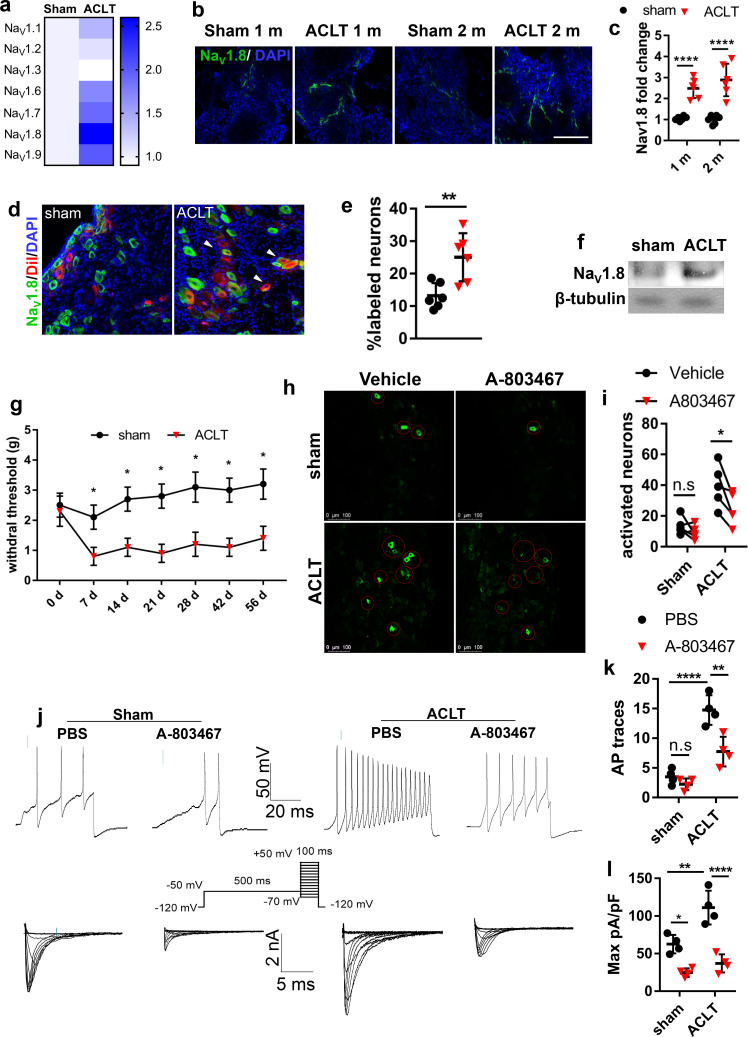
Nav1.8 modification after mice model of OA.(a) Heatmap of relative expression levels of NaV channels in ipsilateral L3-L5 DRGs after sham or ACLT surgery. (b, c) Immunostaining of NaV1.8+ (green) nerve fibers (b) and statistical analysis (c) in mouse tibial subchondral bone after sham or ACLT surgery at 1 m and 2 m. Scale bars, 20 μm, n = 6 per group. (d, e) Immunostaining of NaV1.8+ (green) nerve fibers (d) and statistical analysis (e) in ipsilateral sciatic nerve after sham or ACLT surgery at 1 m. Scale bars, 40 μm, n = 6 per group. (f) Western blots of NaV1.8 in mouse ipsilateral L3-5 DRGs 1 month post sham or ACLT surgery. the experiment was repeated three times and a representative result was chosen. (g, h) Retrograde tracing of Nav1.8 (green) and DiI (red) and DAPI (blue) double-labeled neurons (g) and percentage of double labeled neurons (h) in ipsilateral L4 DRG of rat after sham or ACLT surgery in 3 m. Scale bar, 80 μm. n = 6 per group. (h, i) Representative photomicrographs (h) and statistically analysis of activated neurons (i) in ipsilateral L4 DRG using in vivo Pirt-GCaMP3 imaging treated before or after A803467 1 month post sham or ACLT surgery. n = 6 per group. (j–l) Representative traces of Aps (j upper), maximal current density (j lower), statistical analysis of AP numbers (k) and NaV1.8 currents (l) of DRG 1 month post sham or ACLT. **p<0.01, ***p<0.001, ****p<0.0001 compared with the sham-operated group at different time points. Statistical significance was determined by multifactorial ANOVA WITH BONFERRONI POST HOC TEST (c, k, l), unpaired Student’s t test (e an i) and all data are shown as scattered plots with means ± standard deviations.Figure 1—source data 1.Raw data of Navs QPCR, subchondral Nav1.8 fiber density, Retrograde tracing, Von Frey tests, GcAMP3 imaging, and electrophysiological recordings.Figure 1—source data 2.Full scan of western blots in Figure 1f.